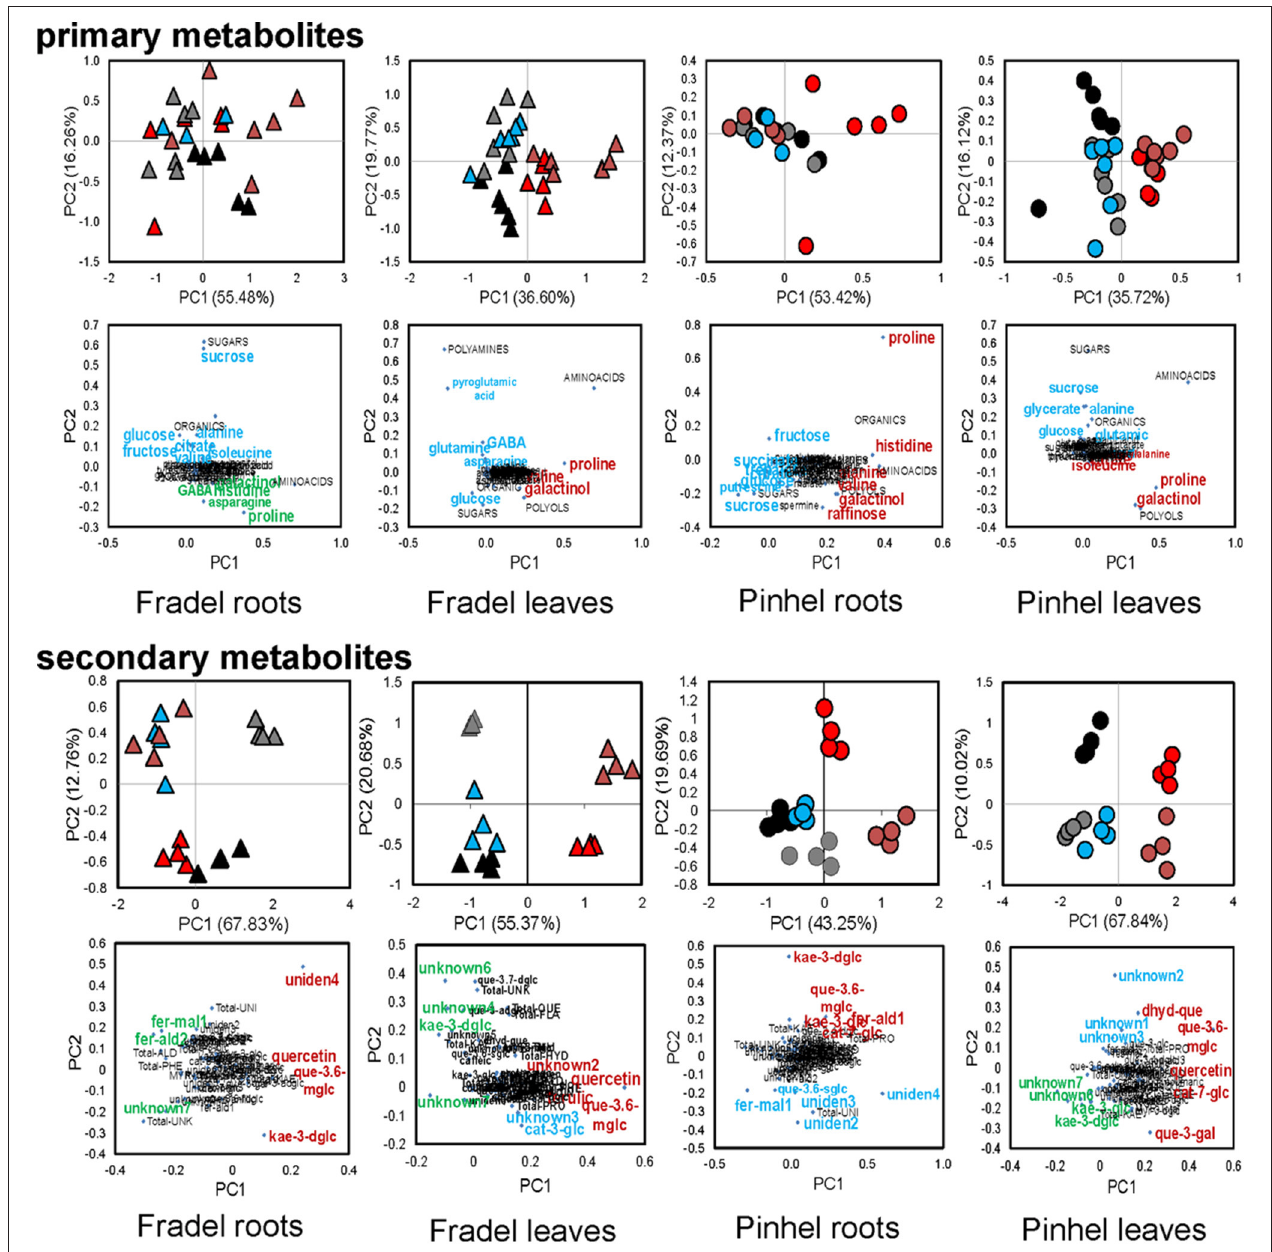
FIGURE 7 | Probabilistic PCA of 41 primary, 35 secondary, and 12 unidentified metabolites detected in cowpea under water deficit and recovery: levels in Fradel (triangles) and Pinhel (circles) roots and leaves that were measured under the following conditions: well watered (black and gray for 6 and 12 days of stress, respectively), drought stressed (red and brown for 6 and 12 days of stress, respectively), and rewatered (blue for plants stressed for 6 days and then rewatered for 6 days). Values representing up to six biological replicates were square root-transformed with pareto scaling. For each group of compounds, the upper plots represent PCA scores of the first two principal components, and lower plots represent the loadings for each compound. The highest positive and negative loadings (Supporting Information Supplementary Table S6 ) associated to metabolic responses to stress/rewatering are tagged in red and green, respectively. Loadings associated with other factors (e.g., sampling time) are highlighted in blue. Metabolites were grouped according to functional categories, indicated in capital letters. For full compound names, please refer to Supporting Information Supplementary Table S3